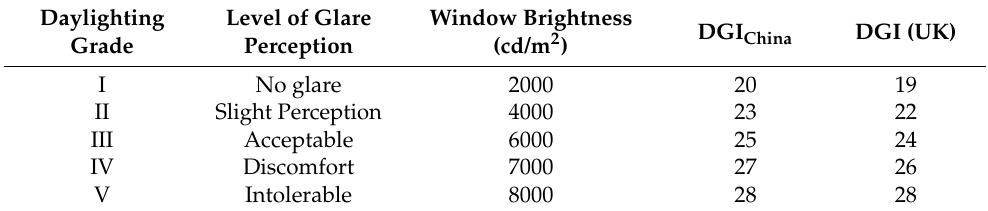
Table 2. Daylighting Grade in China Standard GB